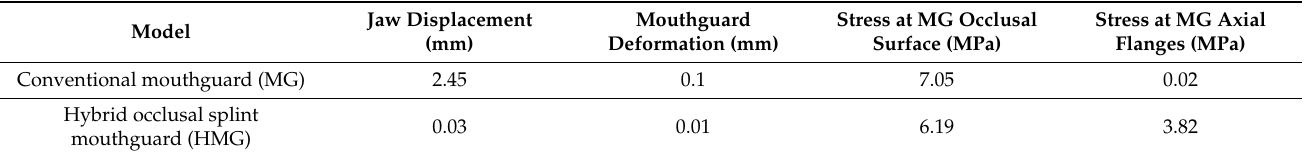
Table 2. Jaw displacement, MG deformation and stresses according to the simulated design.